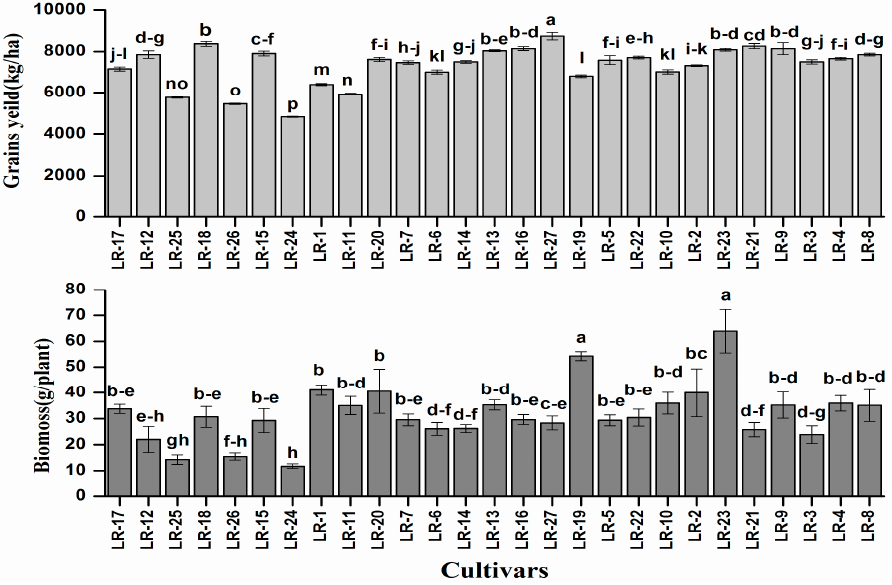
Figure 2. Grain yield and biomass of 27 late rice genotypes grown on Cd contaminated soil. Presented data are means of three replicates, error bars represent standard error. Different letters at the top of bars represent significant difference among the cultivars at p < 0.05.